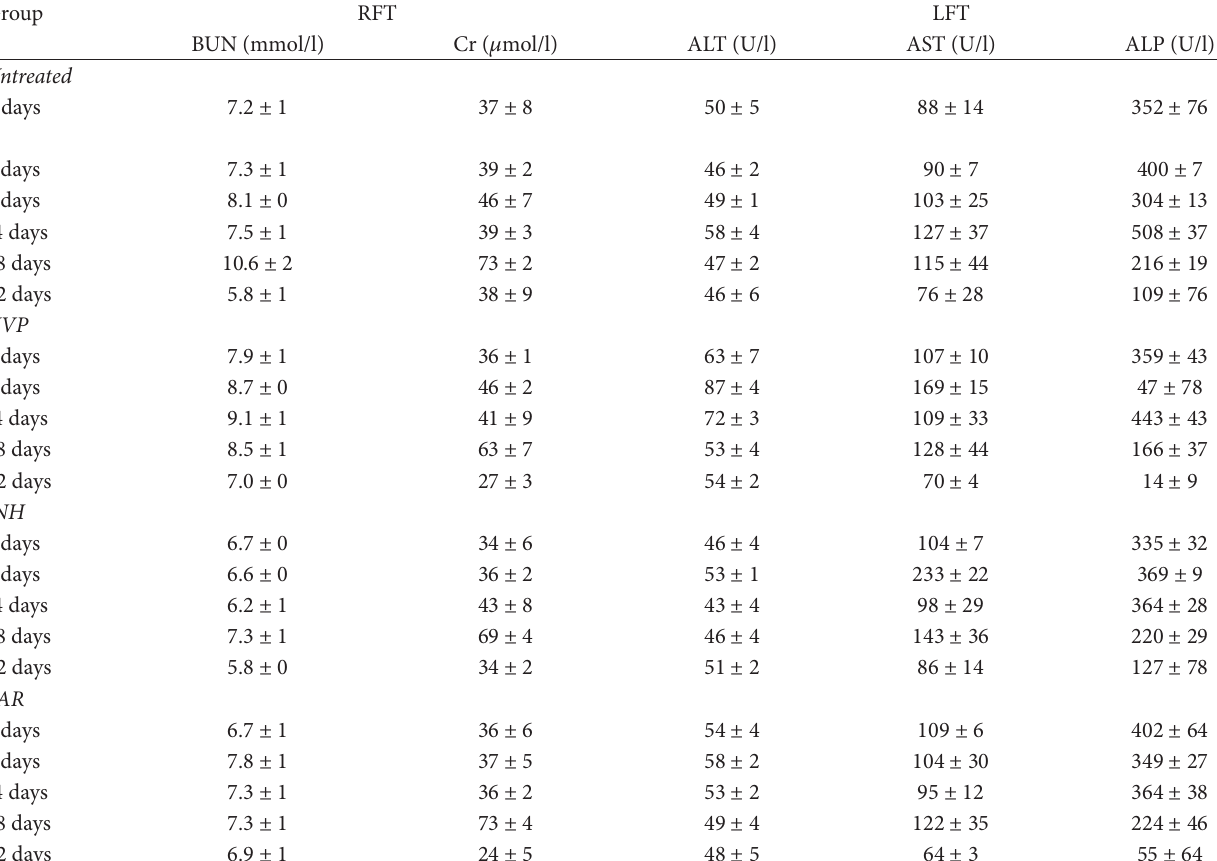
Table 3: Average (mean ± SD) change in renal and liver function tests during treatment of the rats with NVP, INH, and PAR over the study